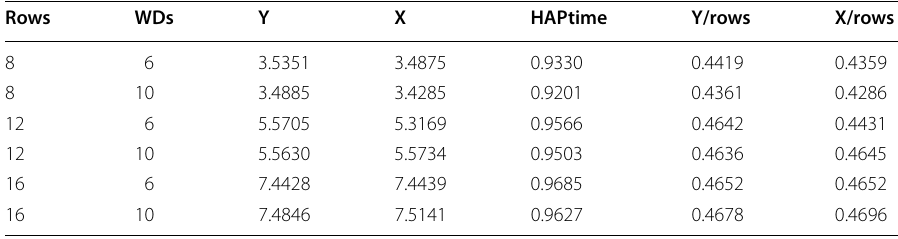
This table describes the average value of some variables from the experimental result using 100 test dataset samples. For 900, ... ,999 in the test dataset, rows, WDs, Y, X, HAPtime, Y/rows each sample WDPM i ( N , M , K ) and TM i ( N , M , K ) , i = and X/rows means the number of rows and wireless devices in WDPM i ( N , M , K ) , the value of n optimal and m optimal , the portion of time allocated to HAP computed with GETTHRPUT function in Algorithm 1 with HAPpoint as [ n optimal , m optimal ], the value of n optimal /rows and m optimal /rows, respectively